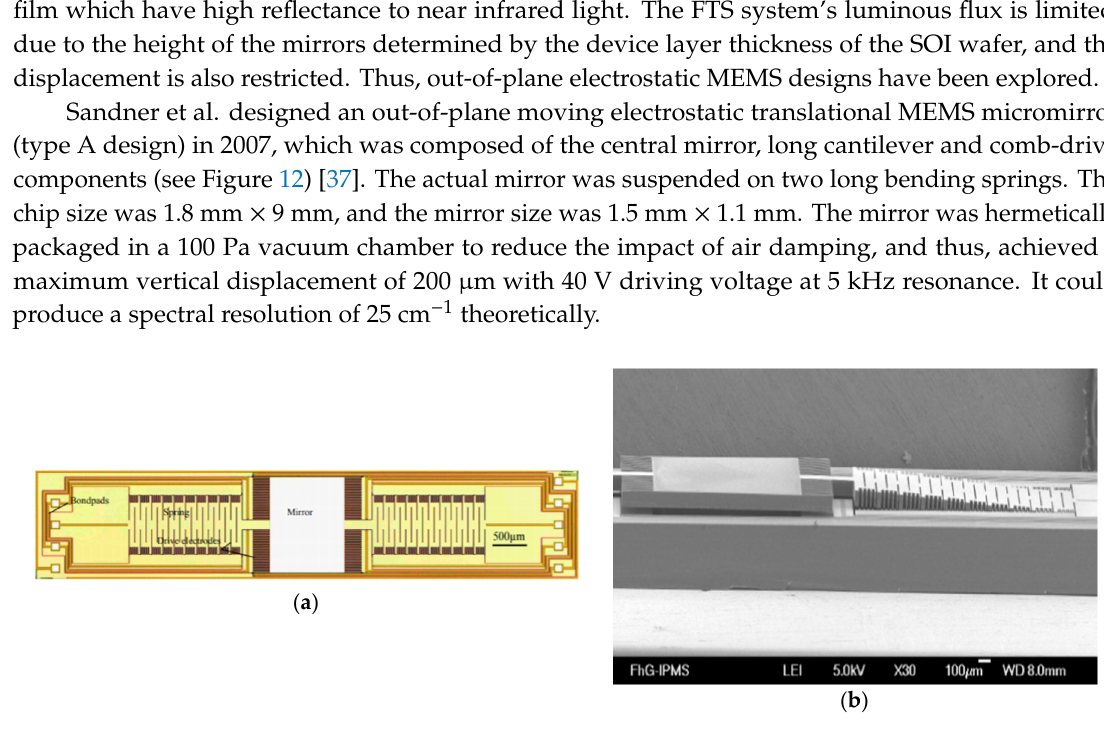
Figure 11. Cascaded FP interferometers based FTS. (Reprinted with permission from Reference [36] SPIE).